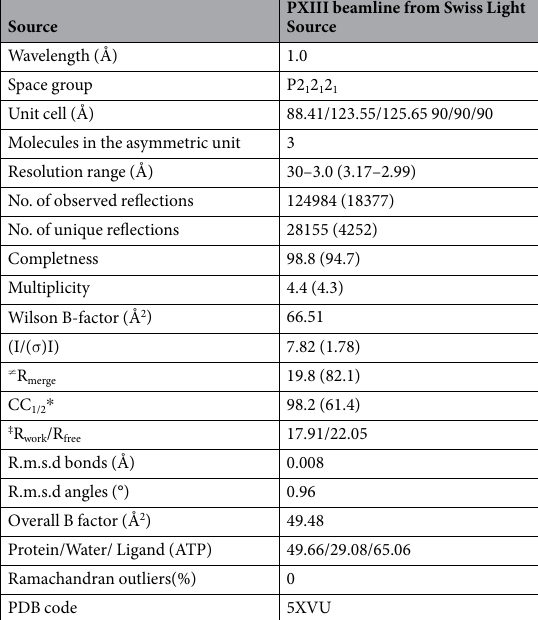
Table 3. Data collection and structure refinement statistics. a The numbers in parentheses refer to the